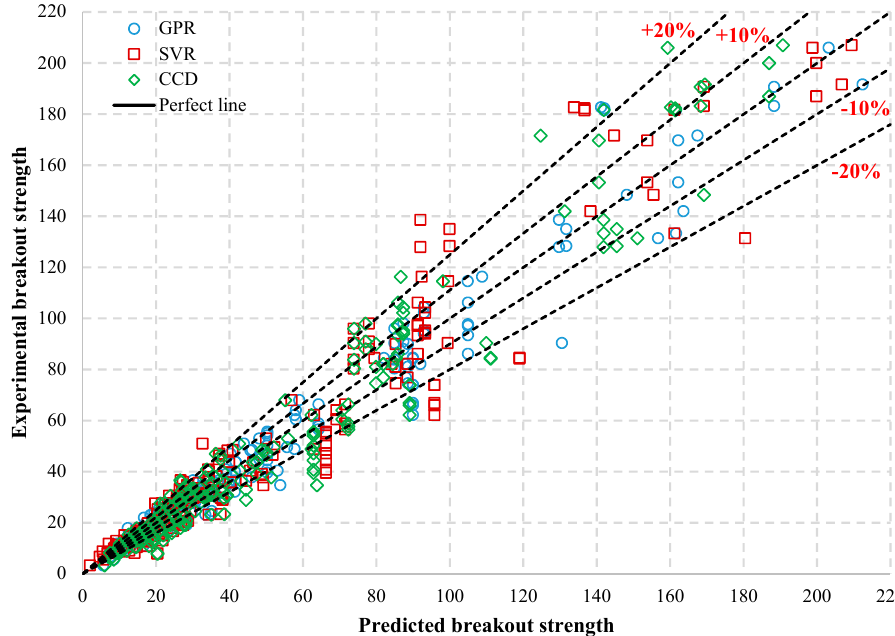
Figure 7. Predicted value versus the experimental value of concrete breakout capacities for the developed models and Concrete Capacity Design (CCD) method.